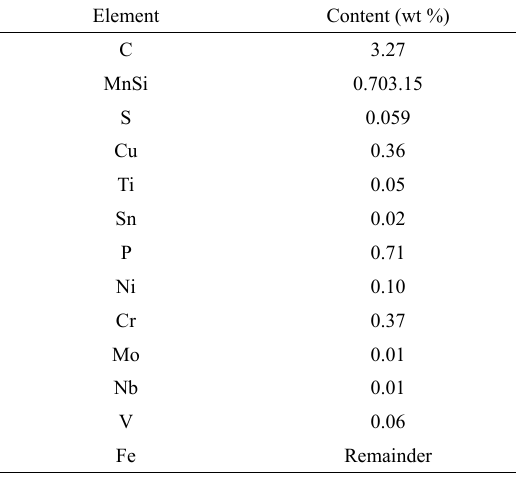
Table 1. Chemical composition of cast iron liner.